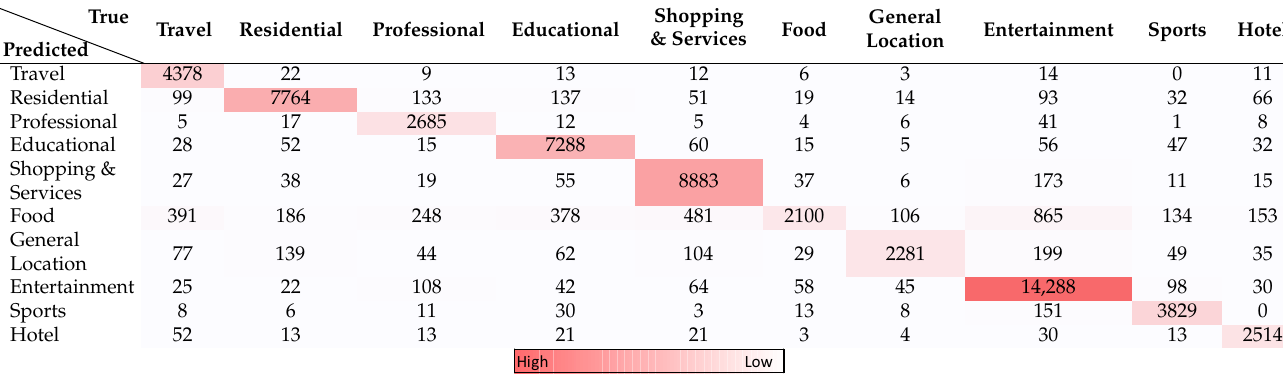
Table 4. Confusion Matrix for Deep-Learning Model. Table 3. Confusion Matrix for Generalized Linear Model.